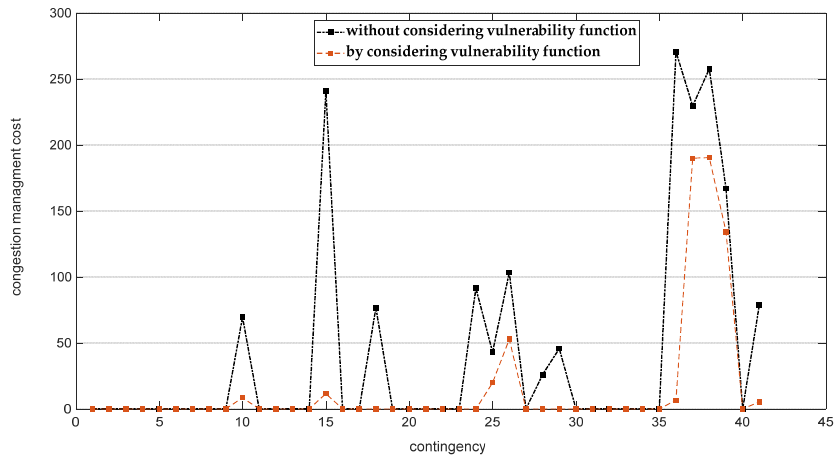
Figure 6. Congestion management cost for the final solution in Cases 1 and 3. Table 6. Average of Resilience Metrics for the Obtained Non-Dominated Set in IEEE 118-Bus Test System.